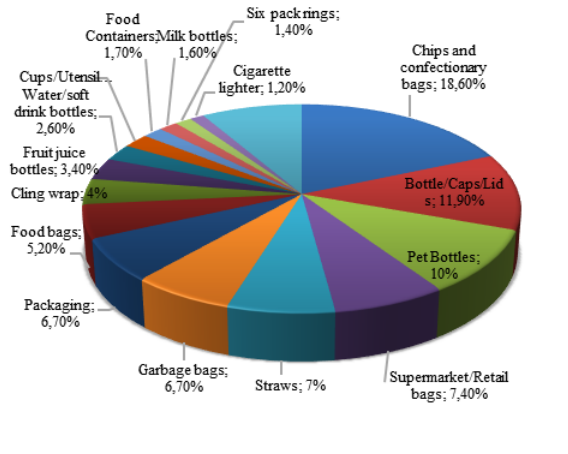
Figure 1. Sources of plastic waste generation Table 1. Consumption of plastic in India by different sectors Plastic consumption